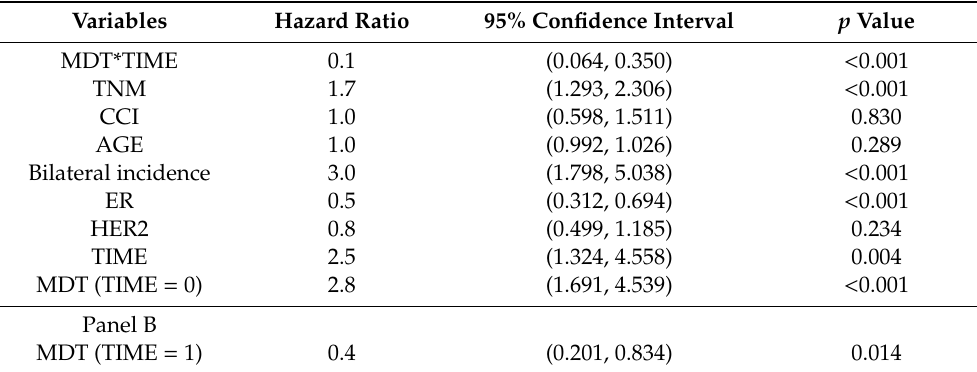
Table 5. The di ff erential e ff ects of MDT in Cox regressions.